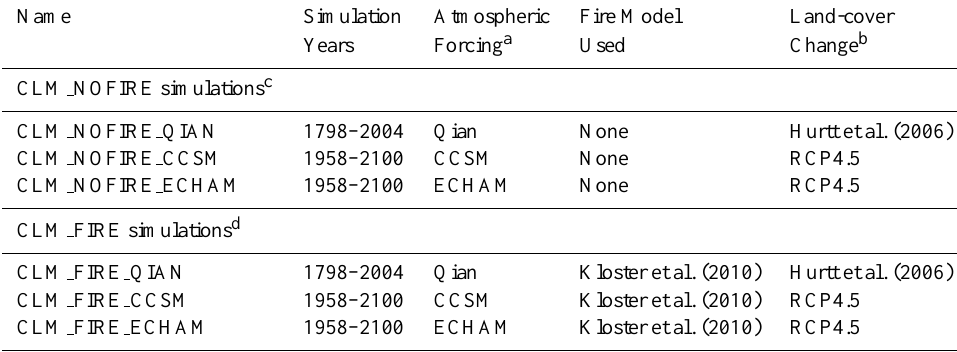
Table 2. Community Land Model (CLM) simulations analyzed in the current